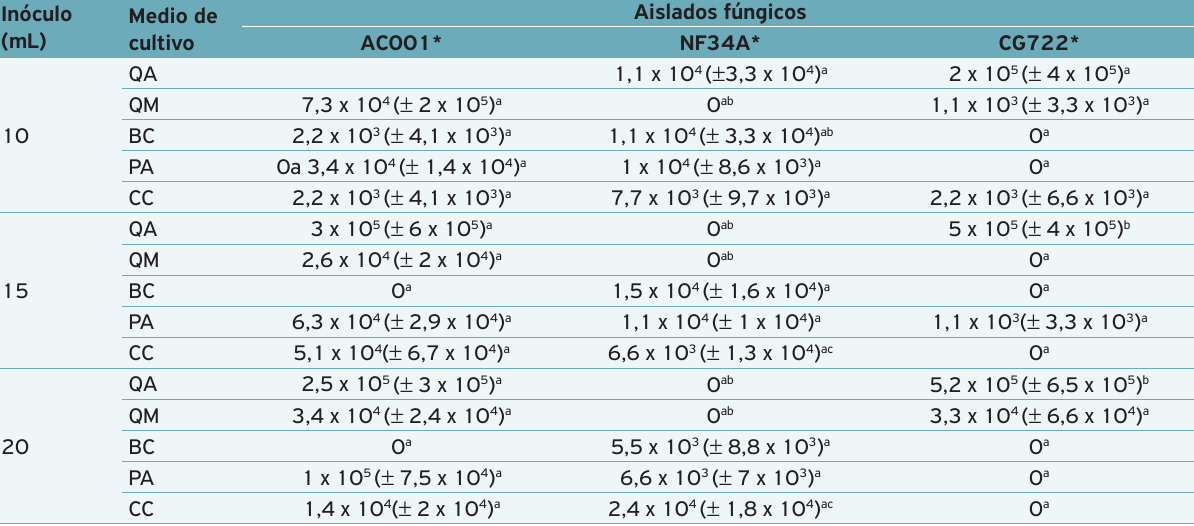
Tabla 1. Promedio de esporas producidas por diferentes aislados fúngicos en variados medios sólidos de cultivo después de siete días de incubación a 25ºC.